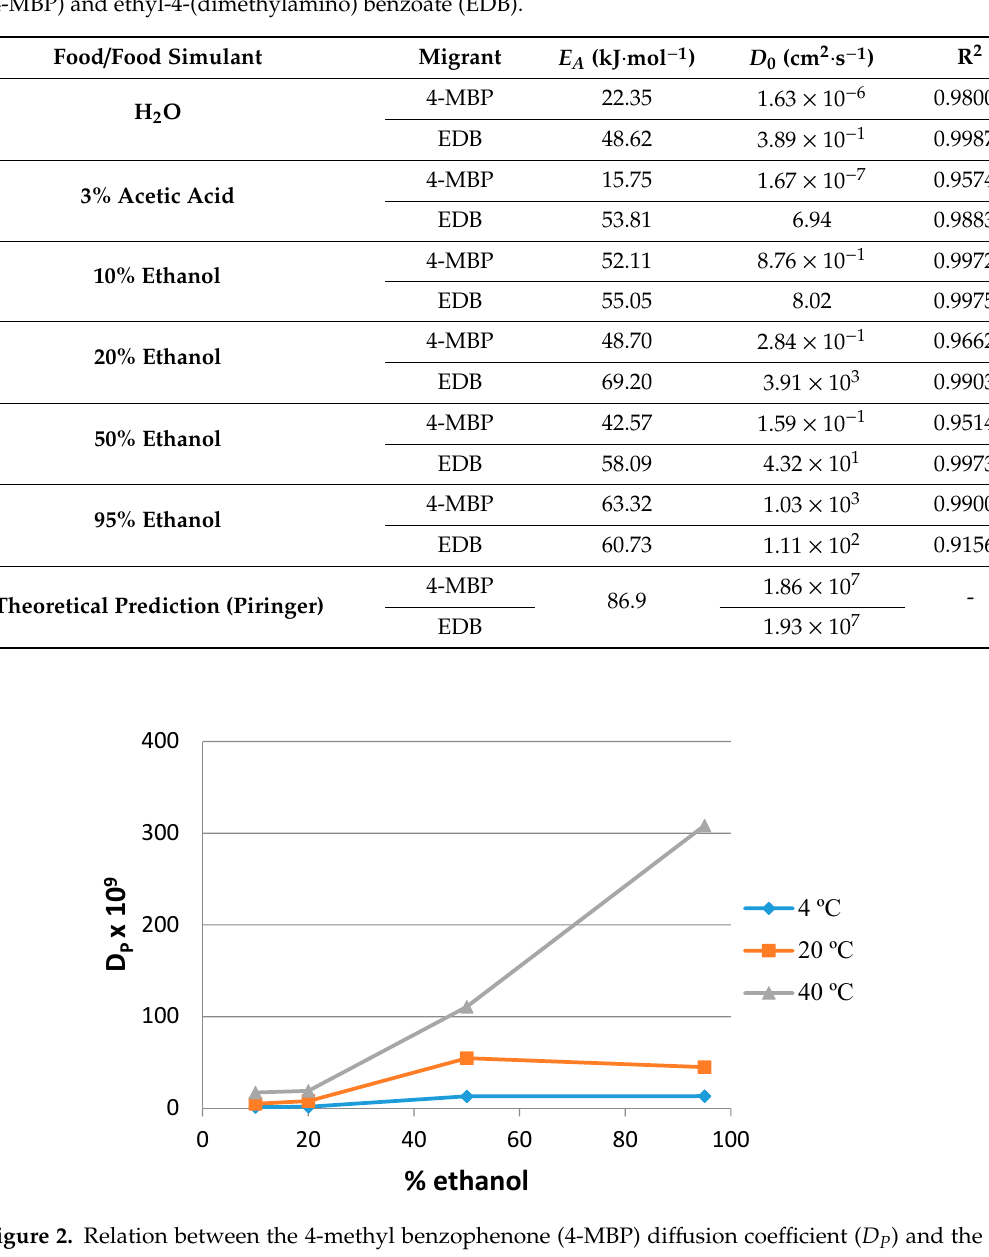
Table 2. Experimental D 0 , E A and R 2 values calculated with equation 3 for 4-methyl benzophenone